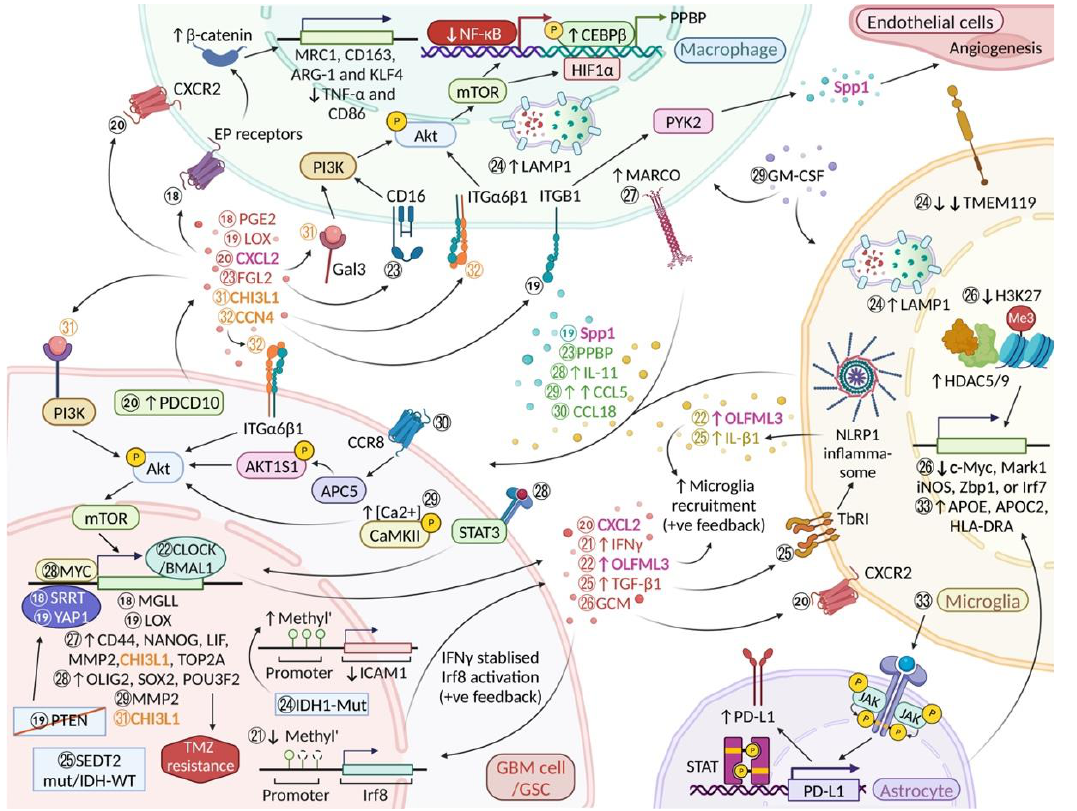
Figure 3. Key pathways involved in microglia/macrophage-glioma intercellular communication.